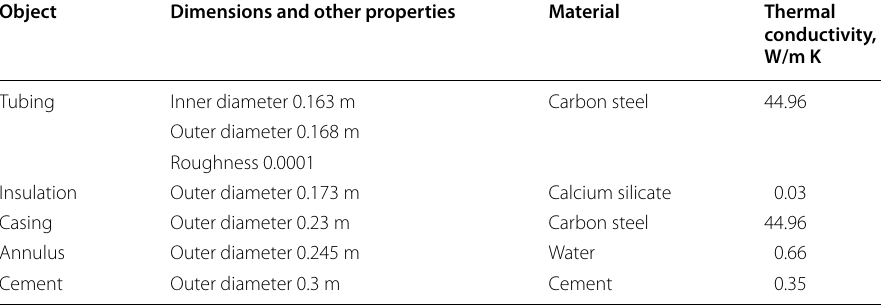
Table 2 Wellbore material properties (Gallup 2003; Engineering Toolbox 2003, 2005, 2008, 2018; Kaya and Hoşhan 2005; Thorbjornsson